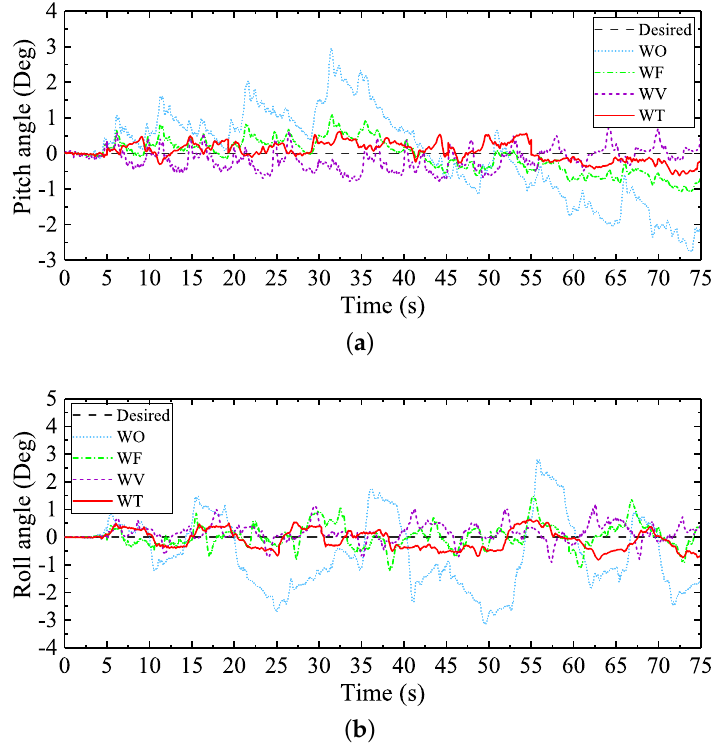
Figure 12. The attitude regulation performances of the pitch and roll angles under different control schemes: ( a ) the body pitch angle comparison and ( b ) the body roll angle